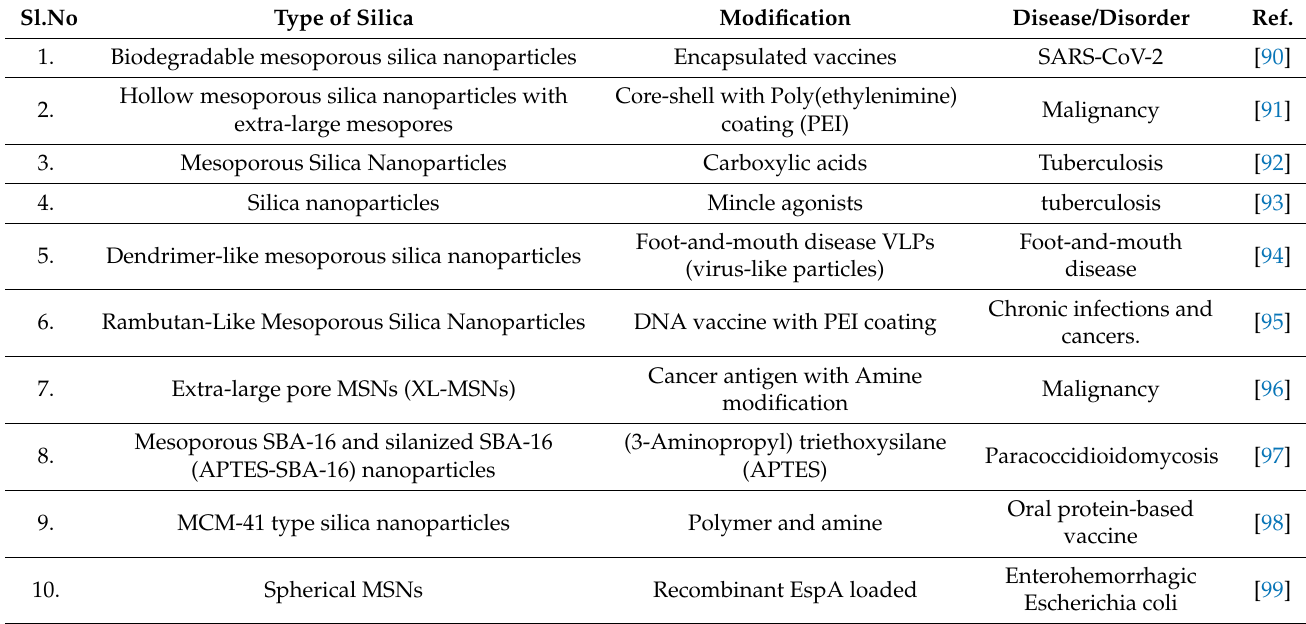
Table 2. Summary of relevant theranostic applications of silica